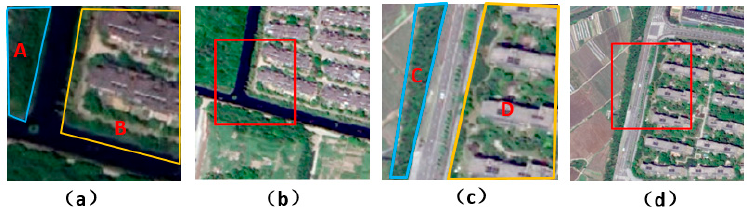
Figure 3. Demonstration of samples. ( a , c ) are samples with “scene distortion”. ( b , d ) show corresponding surrounding environment of ( a , c ). In ( a ), the forest object A is clipped improperly, and there is a large area of urban scene in B. Similarly, in ( c ), the urban scene D is near forest C.